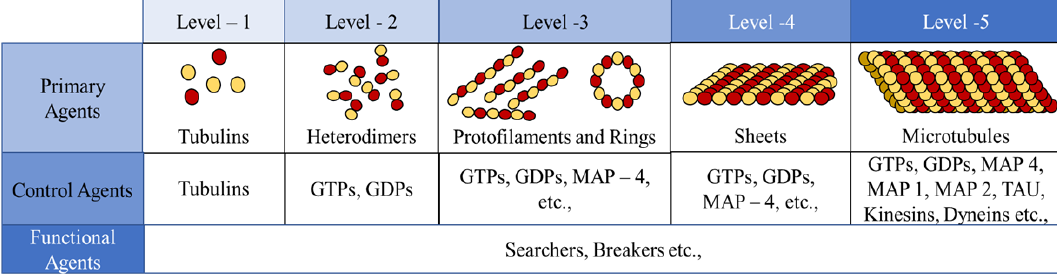
Figure 3. Segregation of agents into different types and levels in our proposed